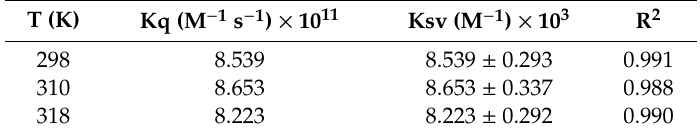
Table 1. Quenching rate constants and Stern–Volmer constants for HSA–AICAR complex.